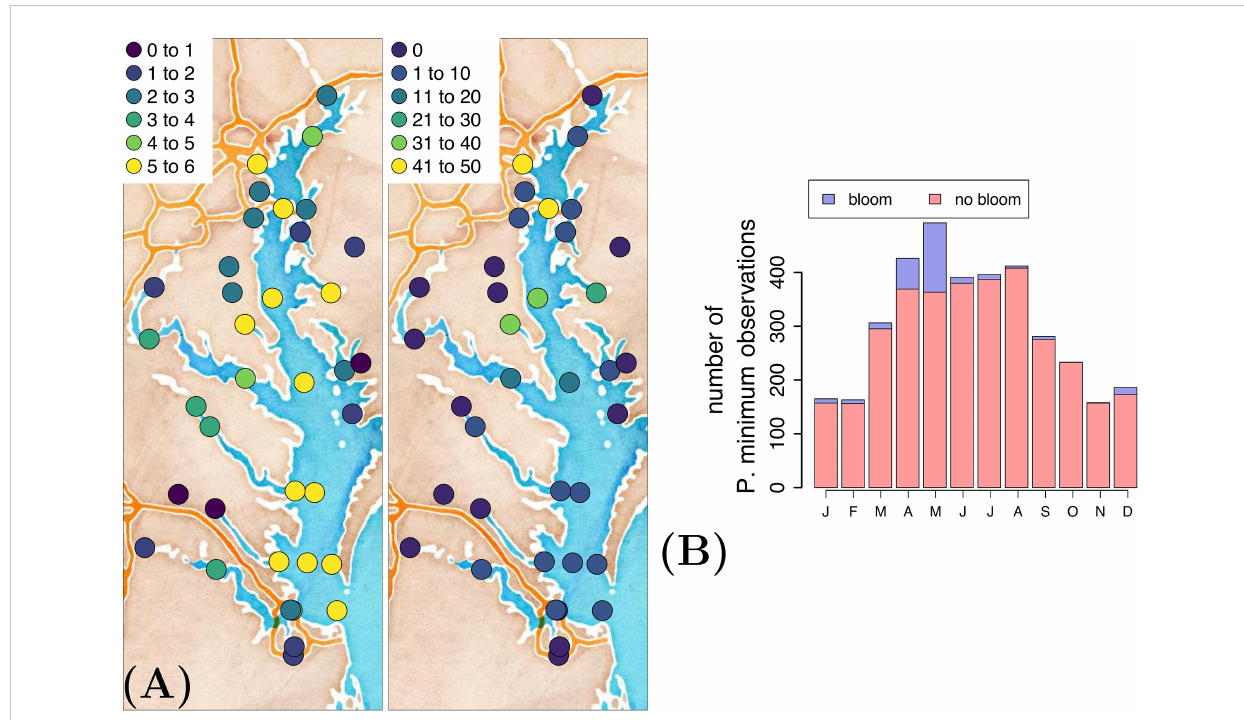
FIGURE 2 (A) Natural logarithmic number of P. minimum observations (left) and number of P. minimum blooms (right), and (B) temporal distribution of the P. minimum observations at 37 stations in surface waters (i.e.,<1 m water